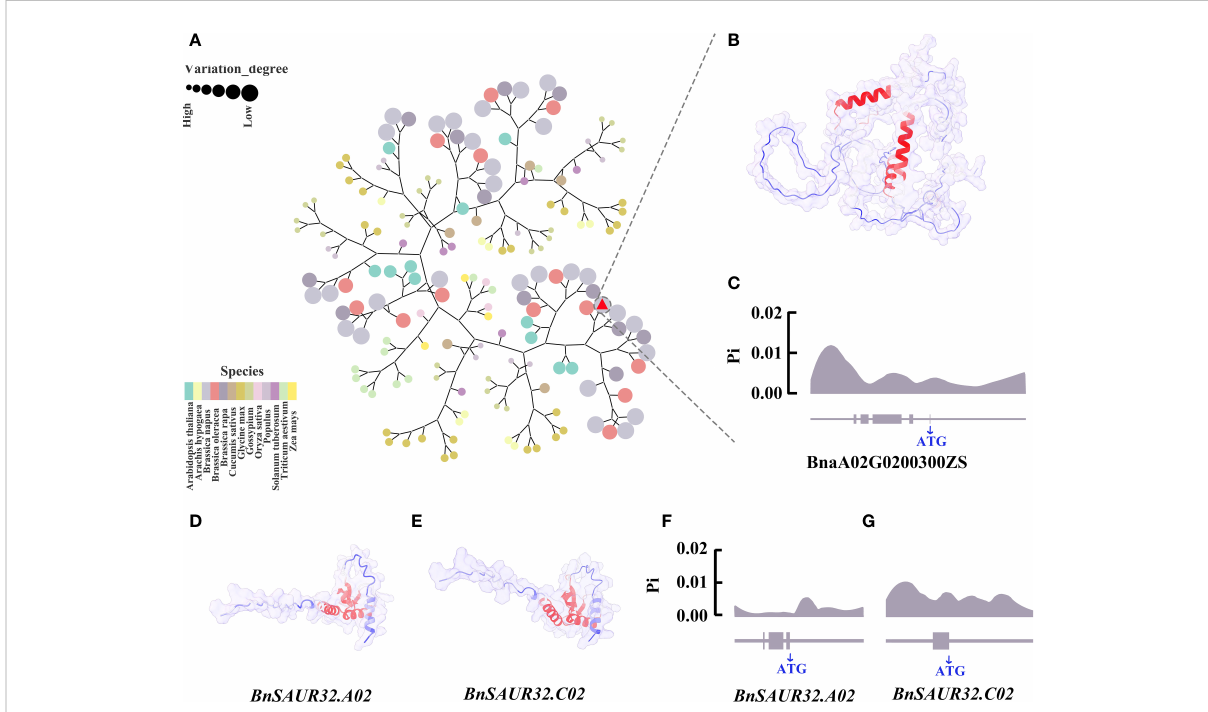
FIGURE 7 Bioinformatics analysis of three key candidate genes (A) Phylogenetic tree of IGT gene family in 13 species, including Arabidopsis thaliana, Arachis hypogaea, Brassica oleracea, Brassica napus, Brassica rapa, Cucumis sativus, Glycine max, Gossypium, Oryza sativa, Populus, Solanum tuberosum, Triticum aestivum and Zea mays . Different colours represent different species, the size of the circle represents the genetic relationship with rapeseed, and the larger the circle, the closer it is to rapeseed. Red triangle marked LAZY4 . (B) Prediction of BnLAZY4.A02 protein structure using Alphafold2. The blue the protein colour, the lower the B-factor, and the red the protein colour, the higher the B-factor. (C) The nucleotide diversity distribution of BnLAZY4.A02 in 289 core germplasm collections; (D) Protein structure map predicted by BnSAUR32.A02 gene. The bluer the protein colour, the lower the B-factor, and the red the protein colour, the higher the B-factor; (E) Protein structure map predicted by BnSAUR32.C02 gene; (F) Distribution of nucleotide diversity of BnSAUR32.A02 gene in 289 core germplasm collections; (G) Distribution of nucleotide diversity of BnSAUR32.C02 gene in 289 core germplasm